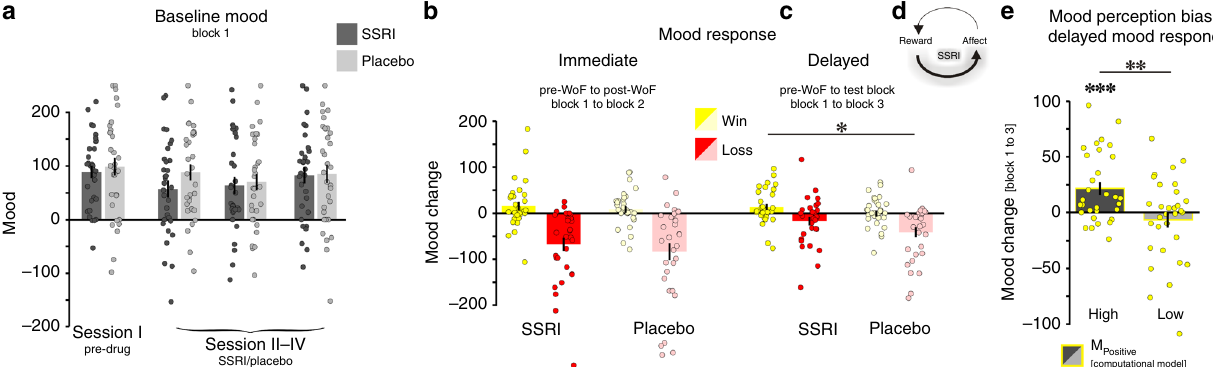
Fig. 5 SSRIs induce mood effects via affect-learning interaction. a Mean mood ratings during the fi rst block of every session, i.e., prior to any mood manipulation. Mood self-reports did not differ between groups in the pre-drug session (session I), or during the 1-week drug period (sessions II − IV). Note that there were similarly no effects on affective state questionnaires, as repeatedly assessed over the course of the study (cf. Supplementary Table 1). b Immediate mood responsivity, as a function of WoF outcome, i.e., mean mood change from block 1 to block 2. WoF outcome profoundly affected emotional state, such that subjects reported to feel happier in the post-WoF block (block 2) after a win and less happy after a loss. However, immediate mood responsivity was unaffected by SSRI treatment. c Delayed mood responsivity, as a function of WoF outcome, i.e., mean mood change from block 1 to block 3. Subjects showed an ongoing mood response during test block (block 3), with elevated mood after a winning draw, and decreased mood after a losing draw. However, delayed mood responsivity was modulated by treatment, such that there was a greater positive mood effect in the SSRI group, and a greater negative mood effect in the placebo group (F 1,62 = 5.6, p = 0.020, n = 64). d Interaction between affect and reward sensitivity. Rewards impact on emotional state, which, in turn, impacts on perception of subsequent rewards. Biased perception of reward, a downstream effect of a serotonergic impact on affect-learning dynamics (cf. Fig. 3b, c), can result in a delayed mood impact of the WoF that was only evident after subjects had played an additional block in which they received more rewards. e Relationship between positive mood perception bias and delayed positive mood response. Subjects with a high positive mood bias parameter, derived from the computational model, showed a strong delayed positive mood response (F 1,30 = 14.6, p < 0.001), an effect not present in subjects with a low mood bias (division using a median split across the whole sample), and that signi fi cantly differed between the two groups (F 1,60 = 9.9, p = 0.002, n = 62). Note that this positive mood bias parameter acts via boosting subjectively perceived reward during learning after winning the WoF, an effect signi fi cantly enhanced in the SSRI as compared to the placebo group. *** p < 0.001, ** p < 0.01, * p < 0.05, n.s. = not signi fi cant (no difference across drug groups). Error bars indicate